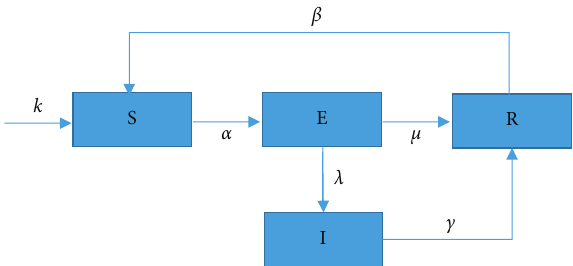
Figure 1: The improved SEIRS